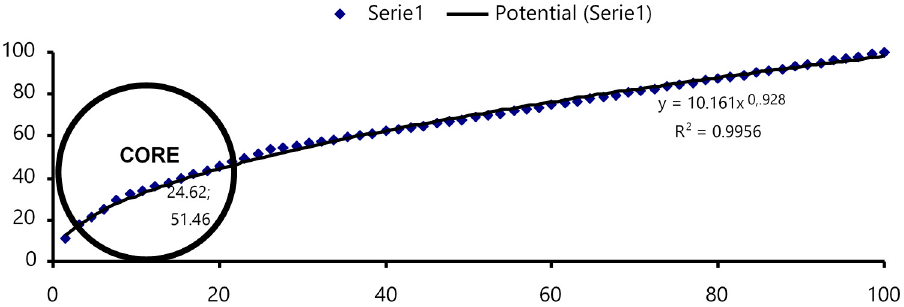
Figure 4. Core Bradford. ( Source: Own elaboration).